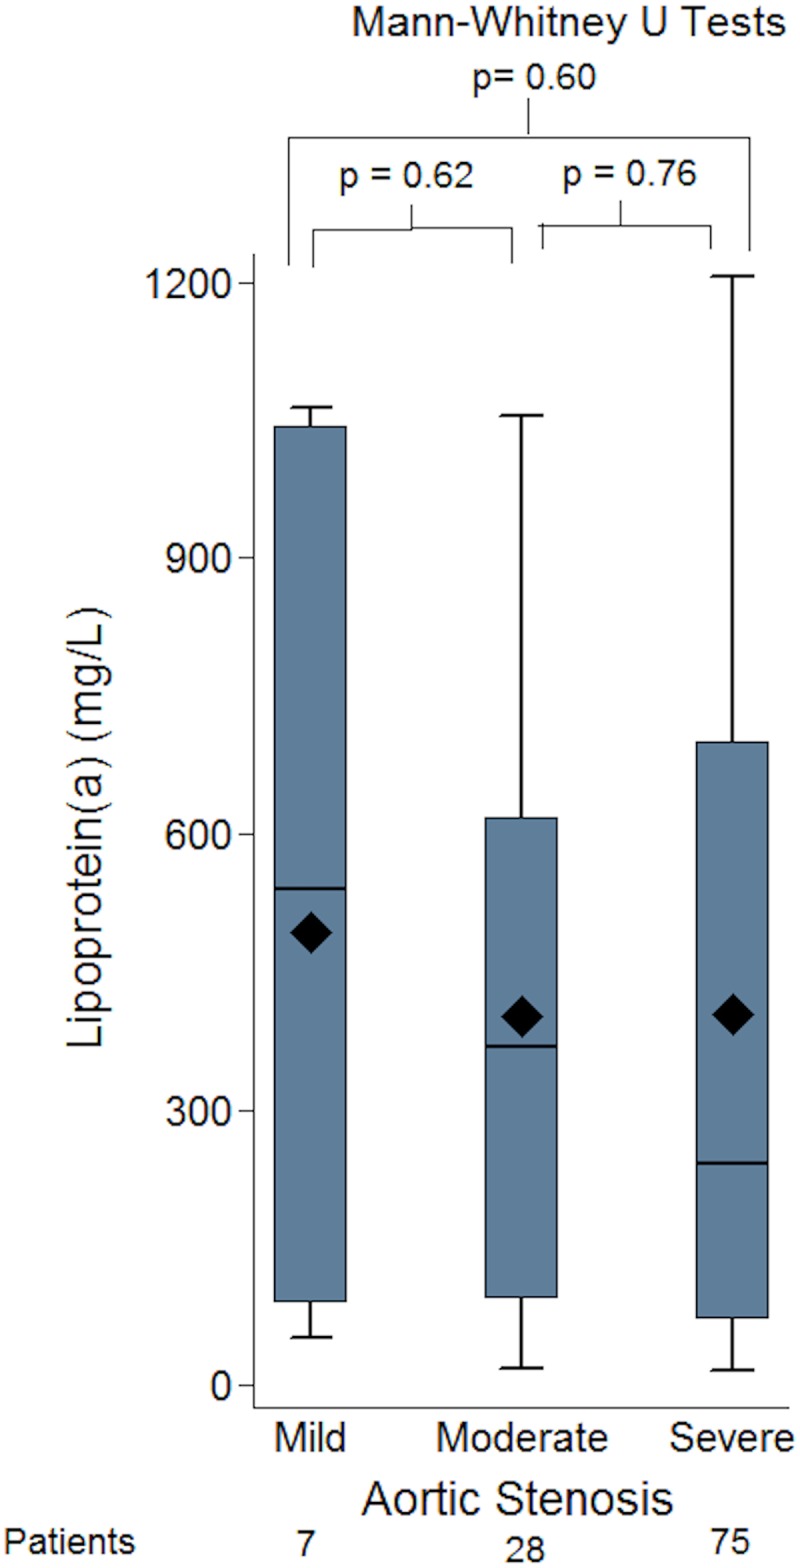
Box-plots of groups of patients with mild, moderate and severe aortic stenosis (AS) and lipoprotein(a) (Lp[a]) level, showing no significant difference between the groups by severity of AS and Lp(a) levels.